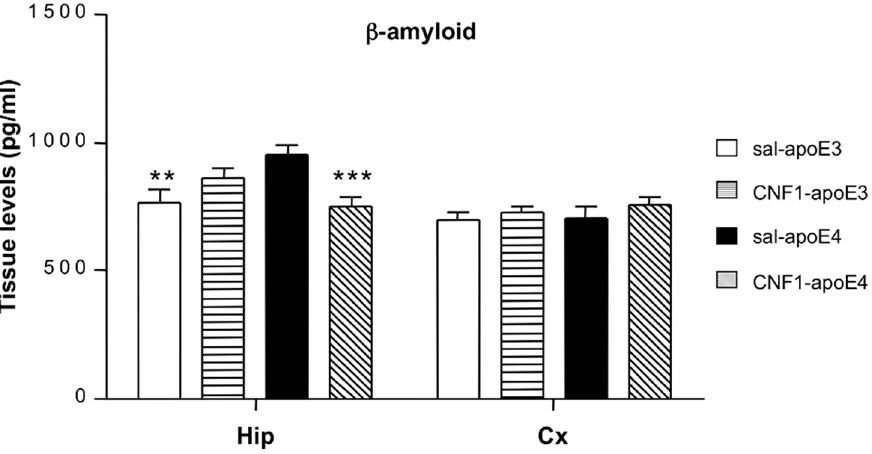
Figure 6. CNF1 treatment diminished A b 42 levels in the hippocampus of apoE4 mice. Hippocampal (Hip) and frontal cortex (Cx) samples from apoE3 and apoE4 mice treated with saline or CNF1 were analyzed by ELISA. CNF1 treatment in apoE4 resulted in a significant decrease in the levels of A b 42 to apoE3 level. No CNF1 effect was observed in apoE3 mice. CNF1 did not induce significant changes in A b 42 levels in apoE3 and apoE4 cortex. Data are shown as mean 6 SEM (pg/ml). Sal-ApoE3 mice were used as reference. *p , 0.05 vs sal-apoE4; ***p , 0.001 vs sal-apoE4, a p , 0.05 sal-apoE3 vs CNF1-apoE3; n=7 per group.